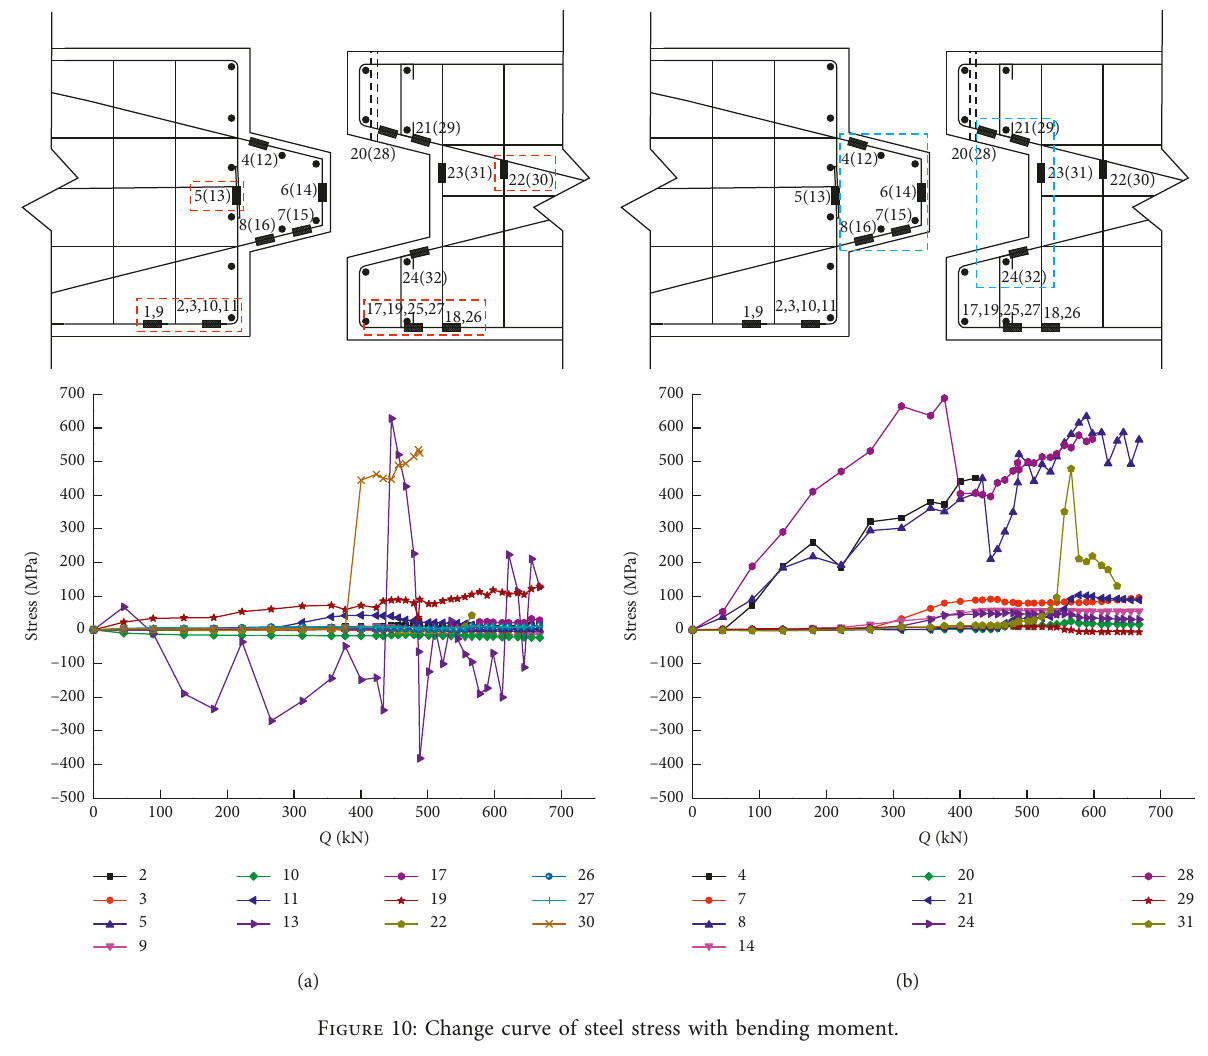
Figure 10: Change curve of steel stress with bending moment.